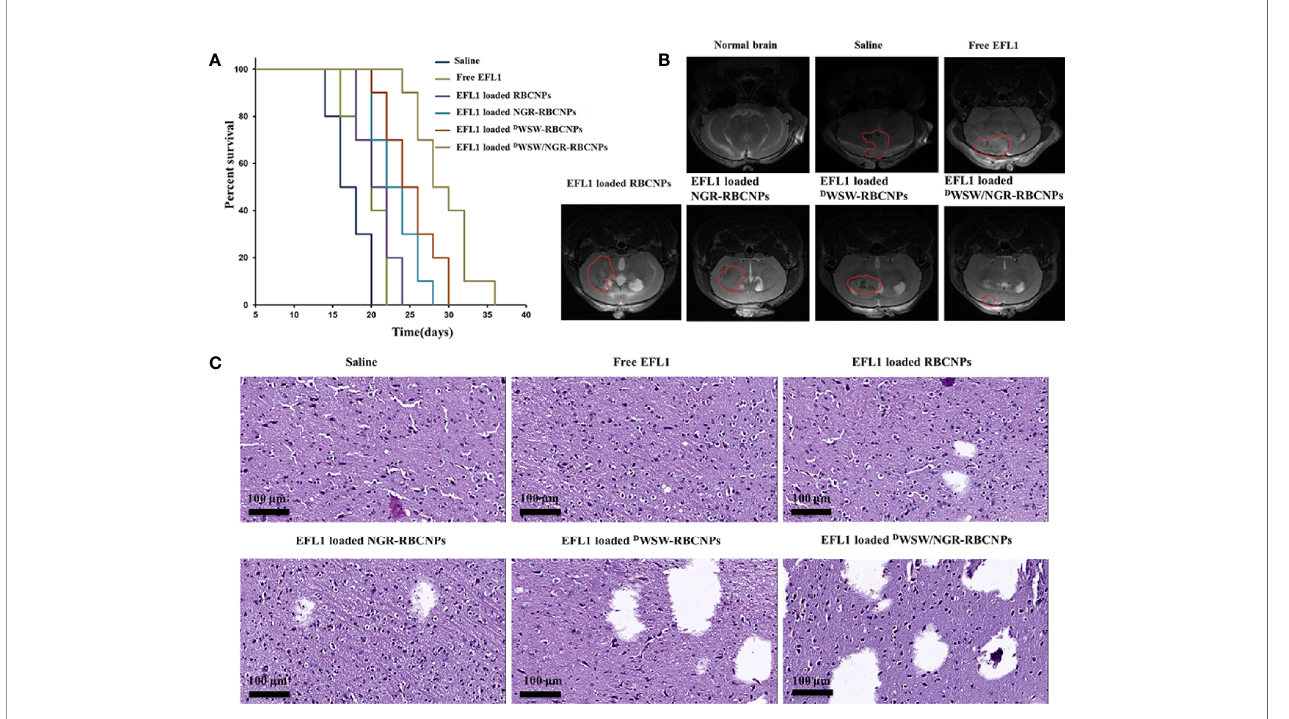
FIGURE 7 | Antitumor effects of nanoparticles in vivo . Kaplan-Meier survival curves of nude mice (A) , brain MRI images (B) , and histological changes in gliomas (C) following treatment with different nanoparticles. The strongest therapeutic effect was achieved by the dual-targeted modi fi ed